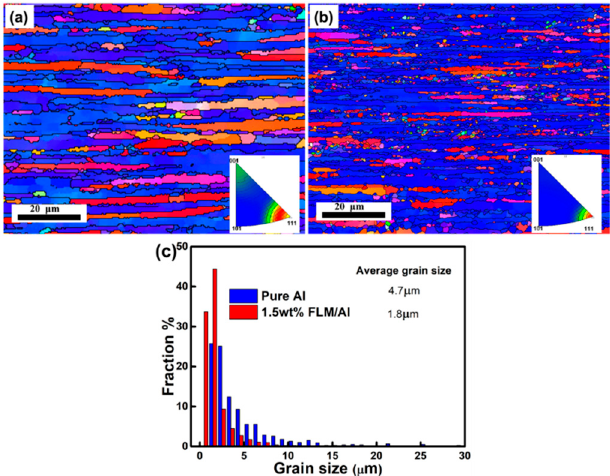
Figure 6. EBSD analysis results: IPF map of ( a ) pure Al, ( b ) 1.5 wt.% FLM/Al composite sintered at 630 °C, and ( c ) grain size distributions.